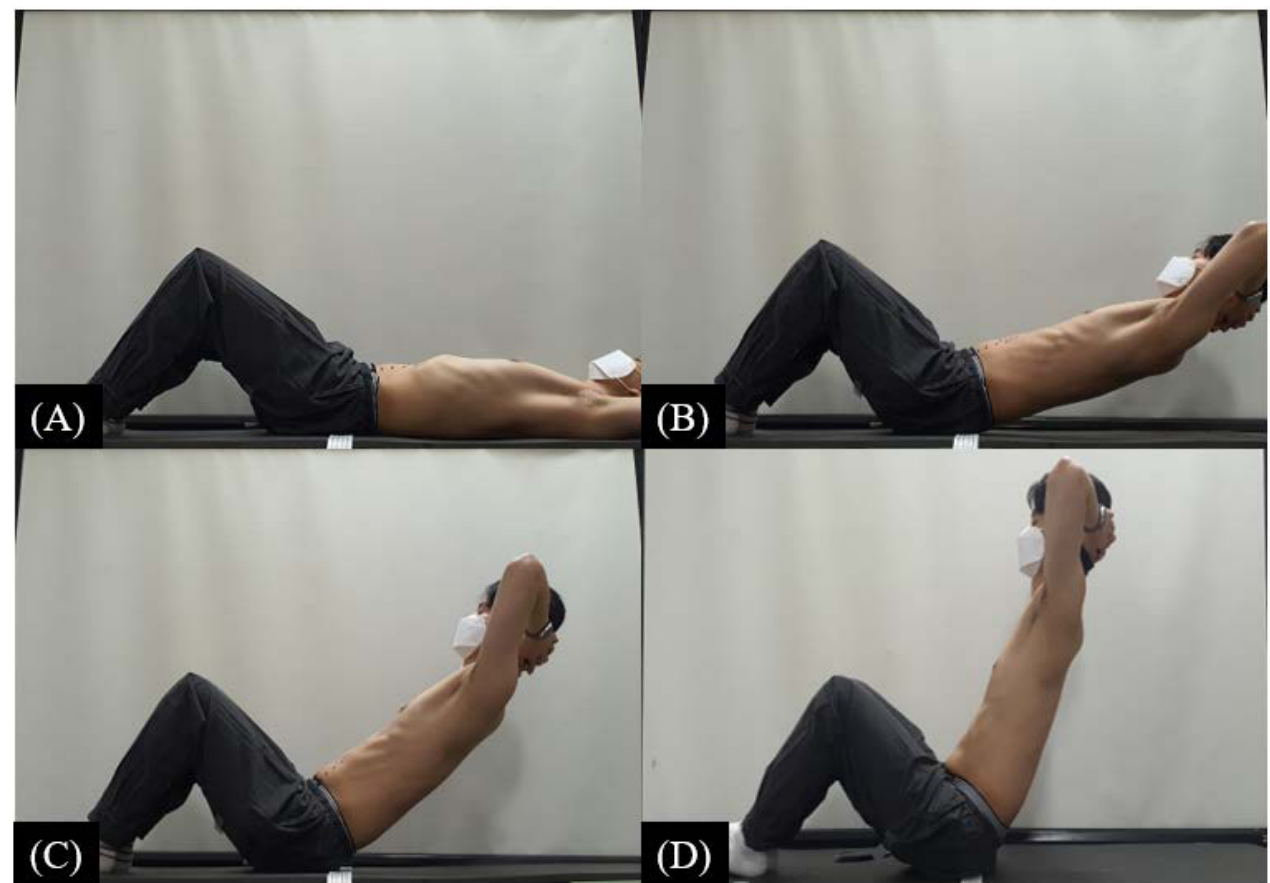
Figure 1. Curl-up posture by angle. ( A ) 0° (rest position) ( B ) 20° ( C ) 40° ( D )